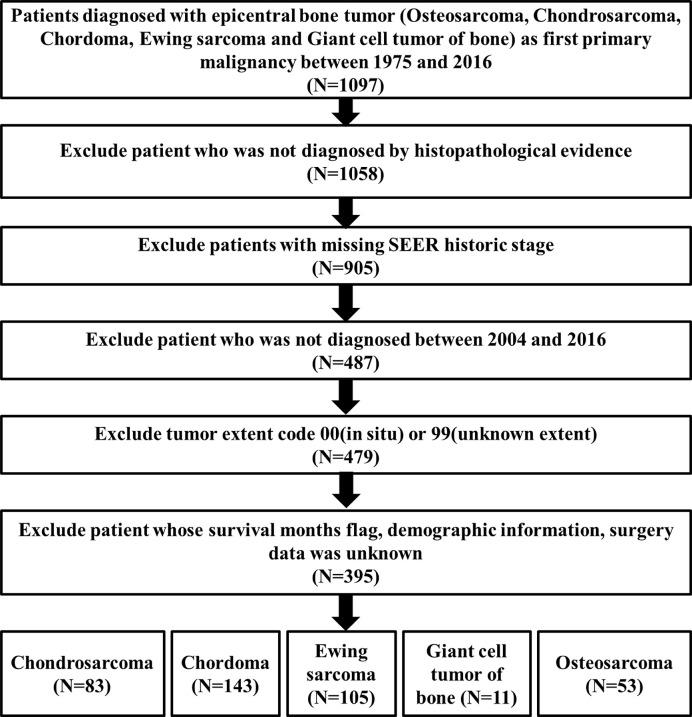
The flowchart of inclusion and exclusion process.